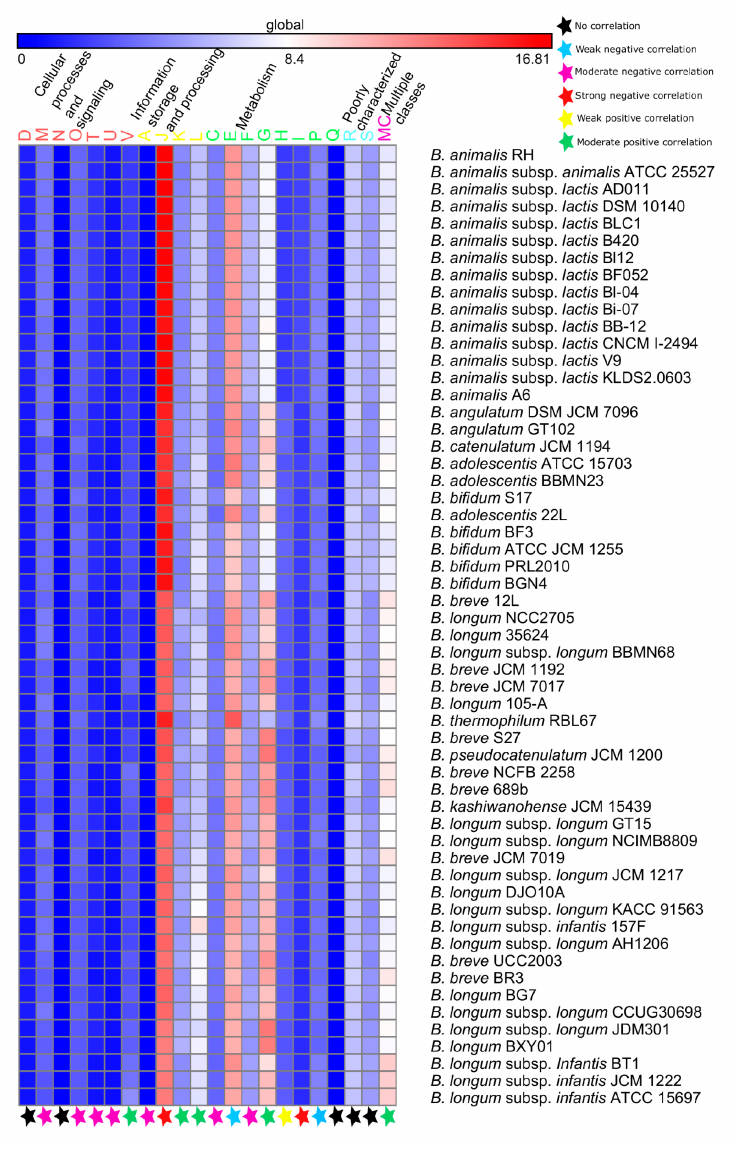
Figure 4. An abundance heat map of the different COGs classes present in the genomes of the 56 PHBifs. The strains are sorted (top to bottom) according to increasing genome sizes. D: Cell cycle control, cell division, chromosome partitioning; M: Cell motility; N: Cell wall/membrane/envelope biogenesis; O: Posttranslational modification, protein turnover, chaperones; T: Signal transduction mechanisms; U: Intracellular trafficking, secretion, and vesicular transport; V: Defense mechanisms; A: RNA processing and modification; J: Translation, ribosomal structure and biogenesis; K: Transcription; L: Replication, recombination and repair; C: Energy production and conversion; E: Amino acid transport and metabolism; F: Nucleotide transport and metabolism; G: Carbohydrate transport and metabolism; H: Coenzyme transport and metabolism; I: Lipid transport and metabolism; P: Inorganic ion transport and metabolism; Q: Secondary metabolites biosynthesis, transport and catabolism; R: General function prediction only; S: Function unknown; MC: Multiple classes. The Spearman’s R statistic ( p -value < 0.001) was used to estimate the significant correlation between the two groups, including COGs class and genome-size, star represents the status of correlation; for details refer to Table